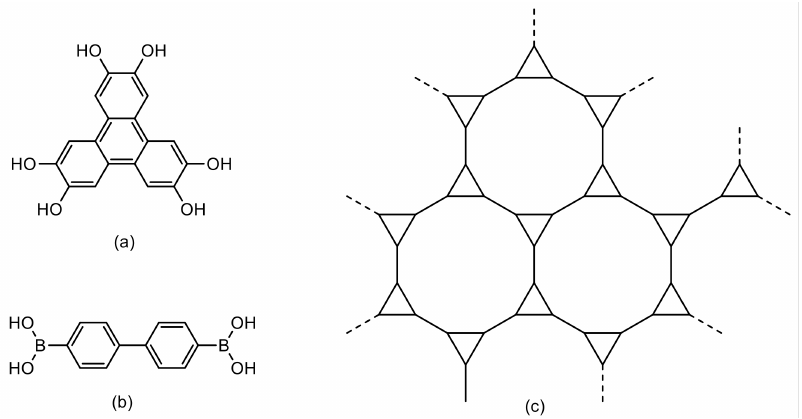
Figure 6. Structures of ( a ) HHTP, ( b ) BPDA and ( c ) schematic representation of COF-10. A carboxylic acid-containing COF, labeled HOOC-COF, and Sr 2+ , Ca 2+ and Mn